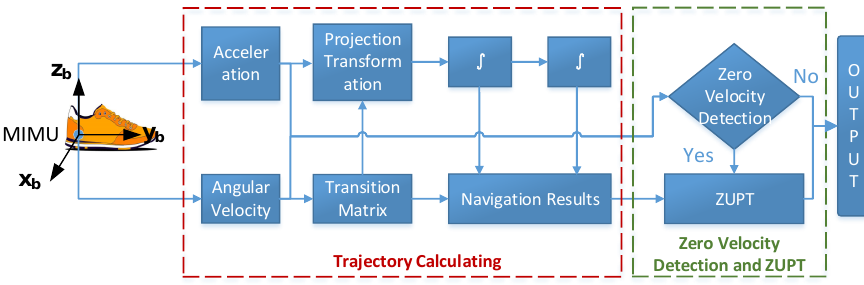
Figure 2 . Basic principle of the dead reckoning algorithm based on ZUPT. Figure 2. Basic principle of the dead reckoning algorithm based on